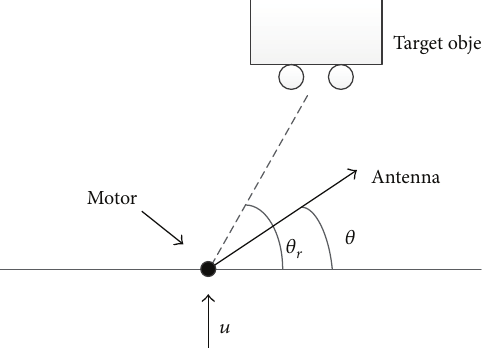
Figure 11: Angular positioning